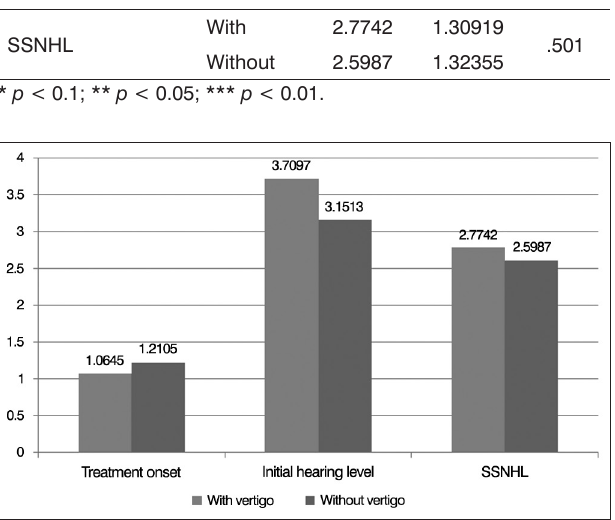
Figure 1. The difference between with vertigo and without vertigo.